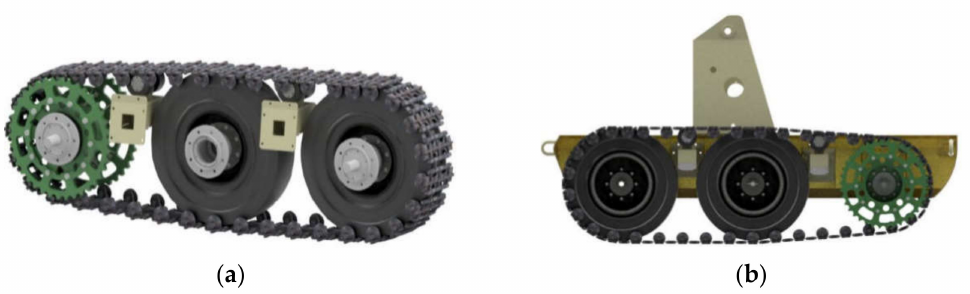
Figure 2. ( a ) A drive-system of the demining machine Božena 5; ( b ) a side-view of a model.